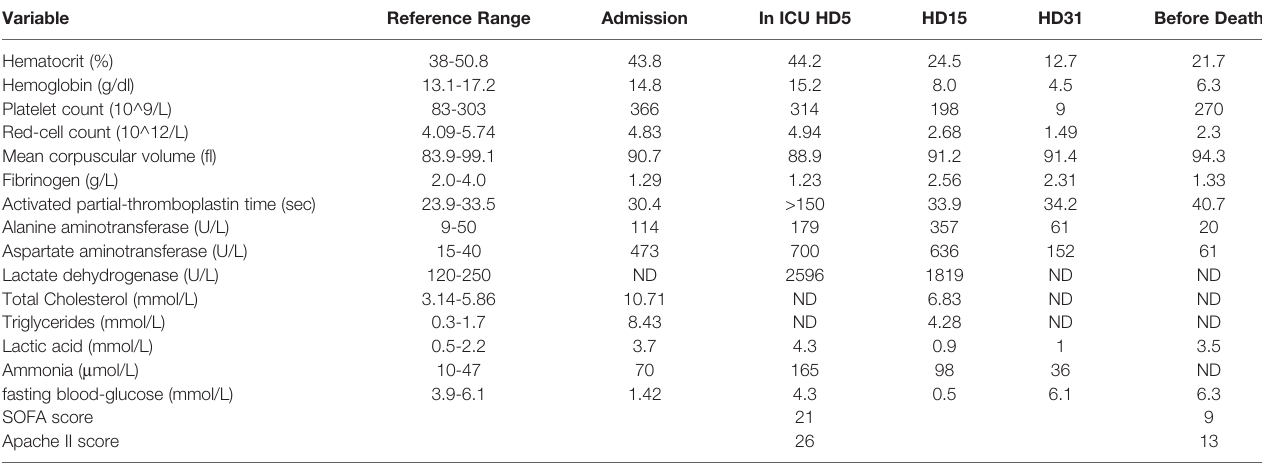
TABLE 1 | Laboratory Data.